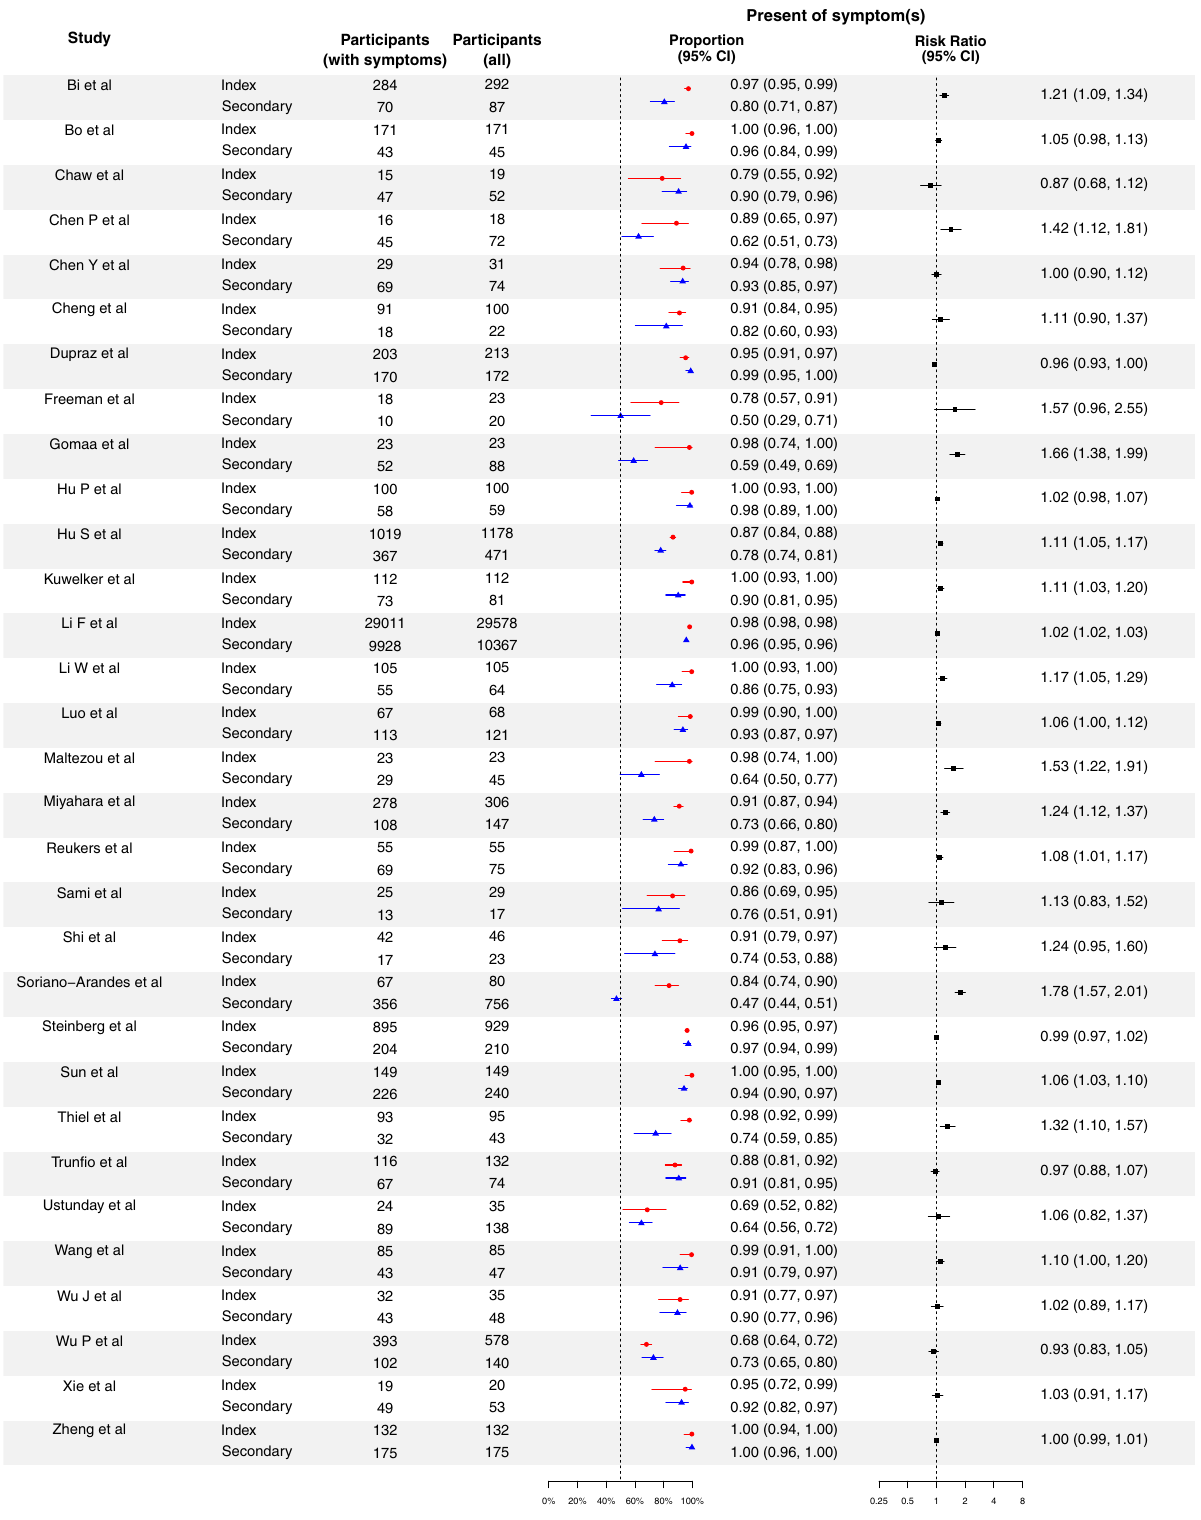
NATURE COMMUNICATIONS| (2021) 12:6372